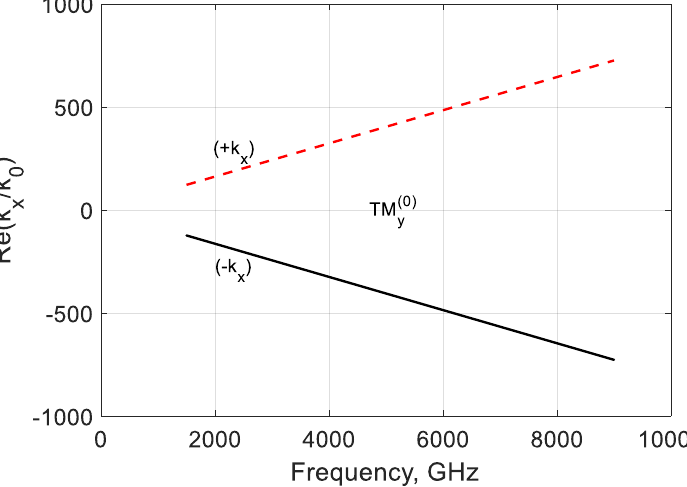
( 0 ) ( 0 ) Figure 11. Normalized real part of the modal propagation constants ∓ k Figure 11. Normalized real part of the modal propagation constants y x / k 0 of the first TM backward mode of a graphene H-waveguide of the height b = 0.01 mm, width 2 a = ∞ , ε r = 3.84 , and backward mode of a graphene H-waveguide of the height µ σ τ = 1 Figure 11. Normalized real part of the modal propagation constants r = 1. Parameters used for calculation of g are from Ref. [21]: T = 300 K, E F = 40 meV, and backward mode of a graphene H-waveguide of the height